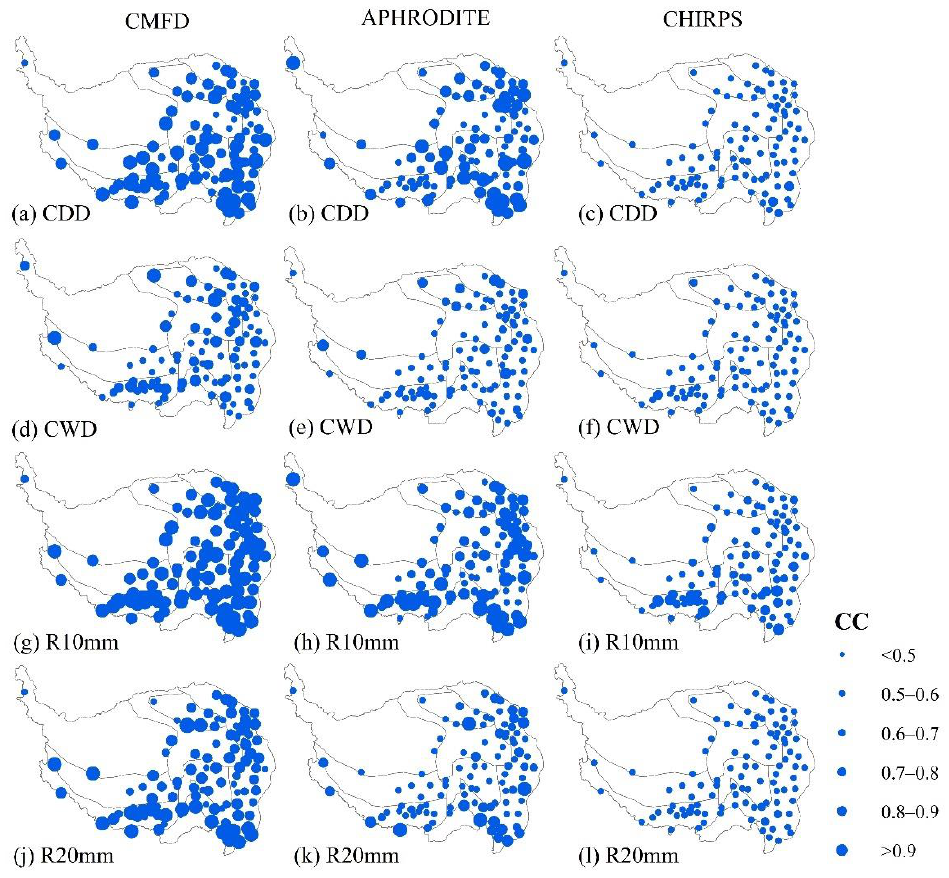
Figure 5. Correlations between gauge-based fixed threshold indices CDD, CWD, R10mm, and R20mm, as derived from CMFD, APHRODITE, and CHIRPS for the period 1981 – 2014.